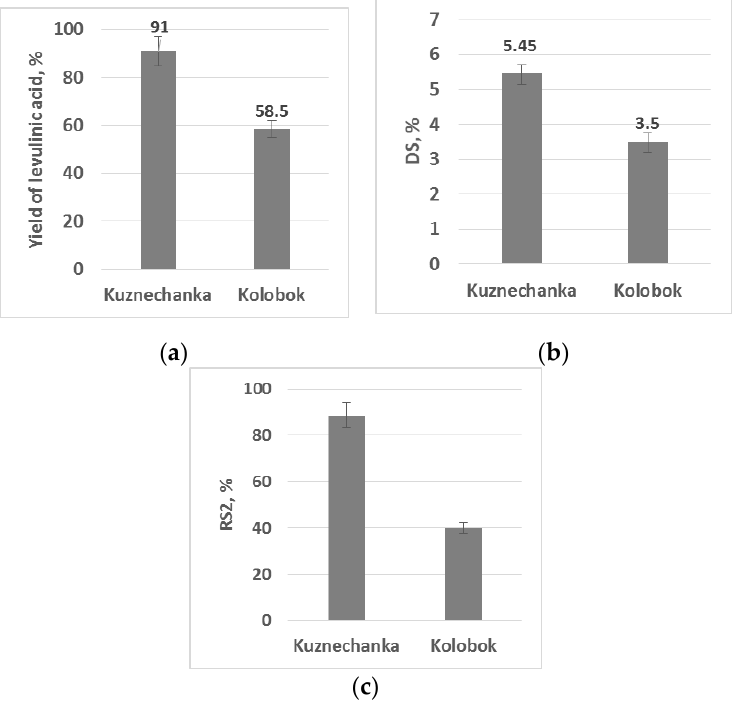
Figure 4. Results of (bio)chemical transformations of starches of potato varieties Kuznechanka and Kolobok: ( a ) yield of levulinic acid 2 (ANOVA: F = 21.89, F critical = 18.51, p = 0.043); ( b ) degree of substitution (DS) in the biocatalytic reaction with enanthic acid (ANOVA: F = 24.93, F critical = 18.51, p = 0.038); ( c ) resistant starch (ANOVA: F = 139.93, F critical = 7.71, p = 0.00029).